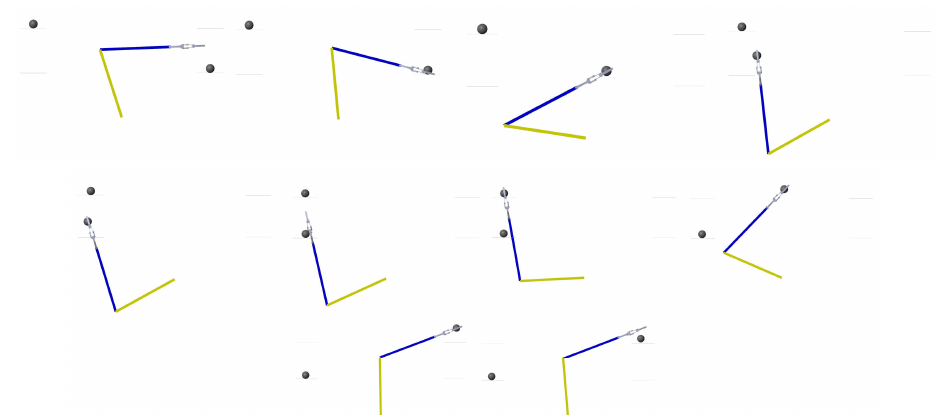
Figure 17. Simulation sequence of robotic manipulation using force